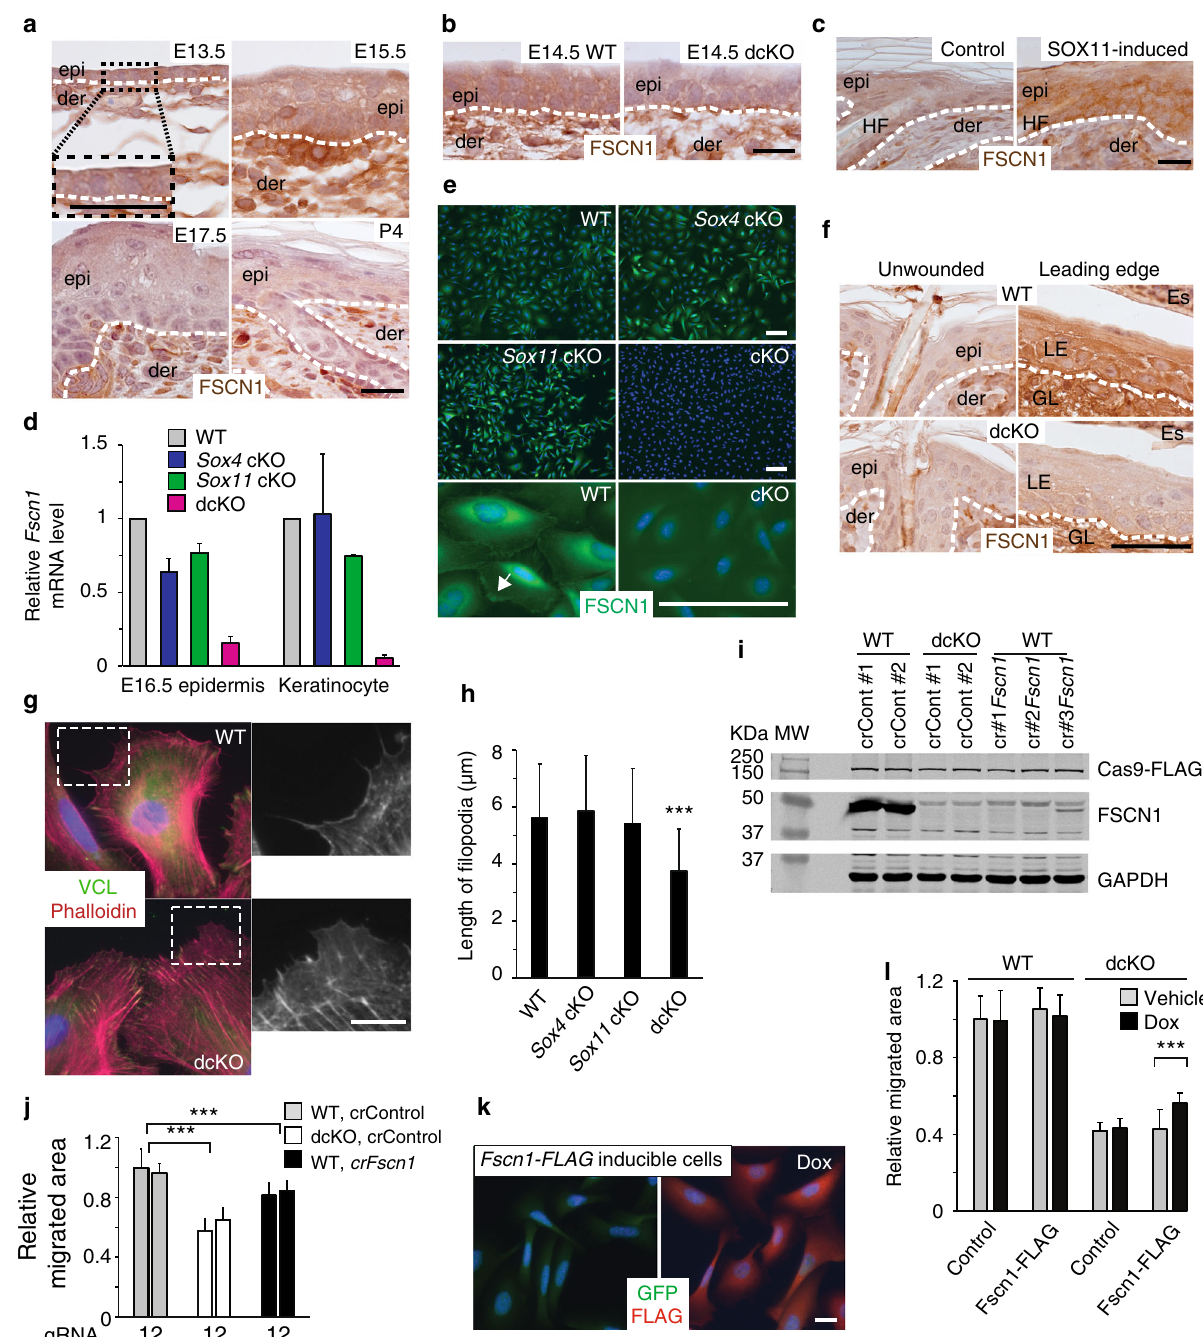
Mice from both genders were used in experiments. All mice were maintained in the AALAC-accredited animal facility at Baylor College of Medicine and were used according to our protocol (AN-4907) approved by the Baylor College of Medicine institutional care and use committee. Barrier permeability and X-gal exclusion assay . Mice were time-mated within a 10 h mating window and the mid-point of the mating window designated gesta- tional age zero. X-gal exclusion assays were performed on embryos. Immediately after tails were snipped for genotyping, embryos were immersed in a low-pH